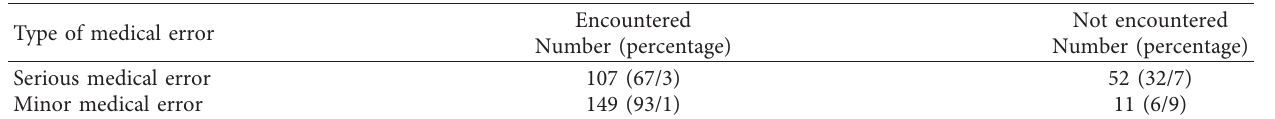
Table 2: Types of medical error and the rate of